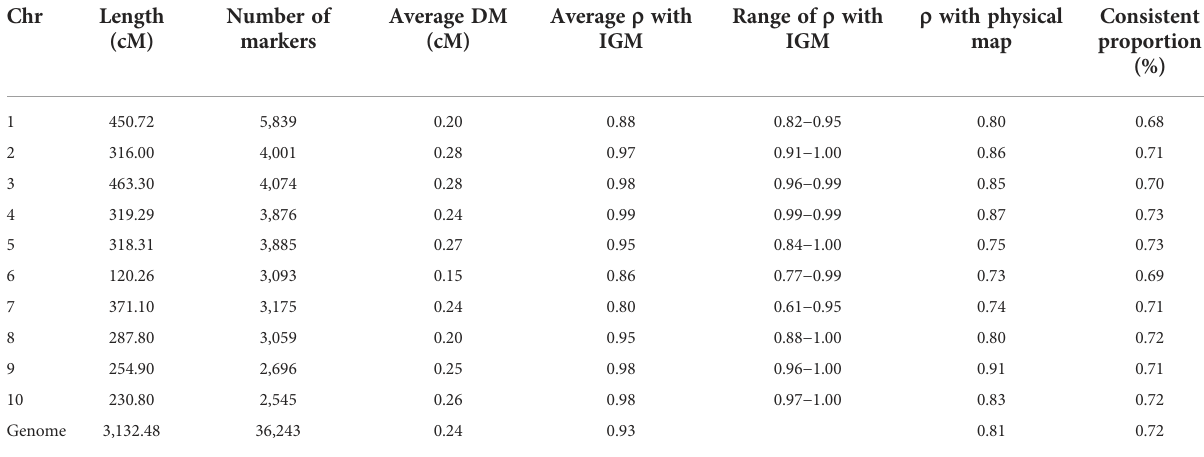
Chr, chromosome; DM, distance between markers; r , Spearman rank correlation coef fi cient; IGM, individual genetic maps used for the consensus map construction. Physical map was obtained from the reference map B73 RefGen_v2. Consistent proportion is the proportion of markers arranged in the same order with those on the corresponding chromosomes of